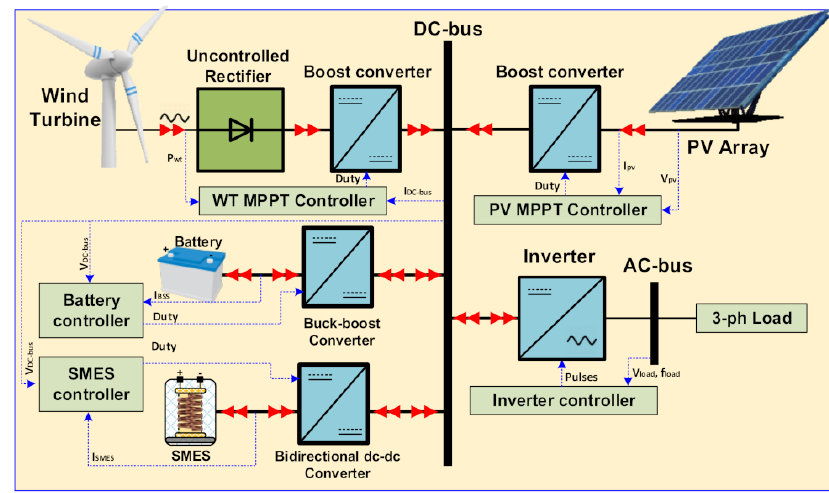
Figure 2. Schematic diagram of the whole system with the proposed controllers.